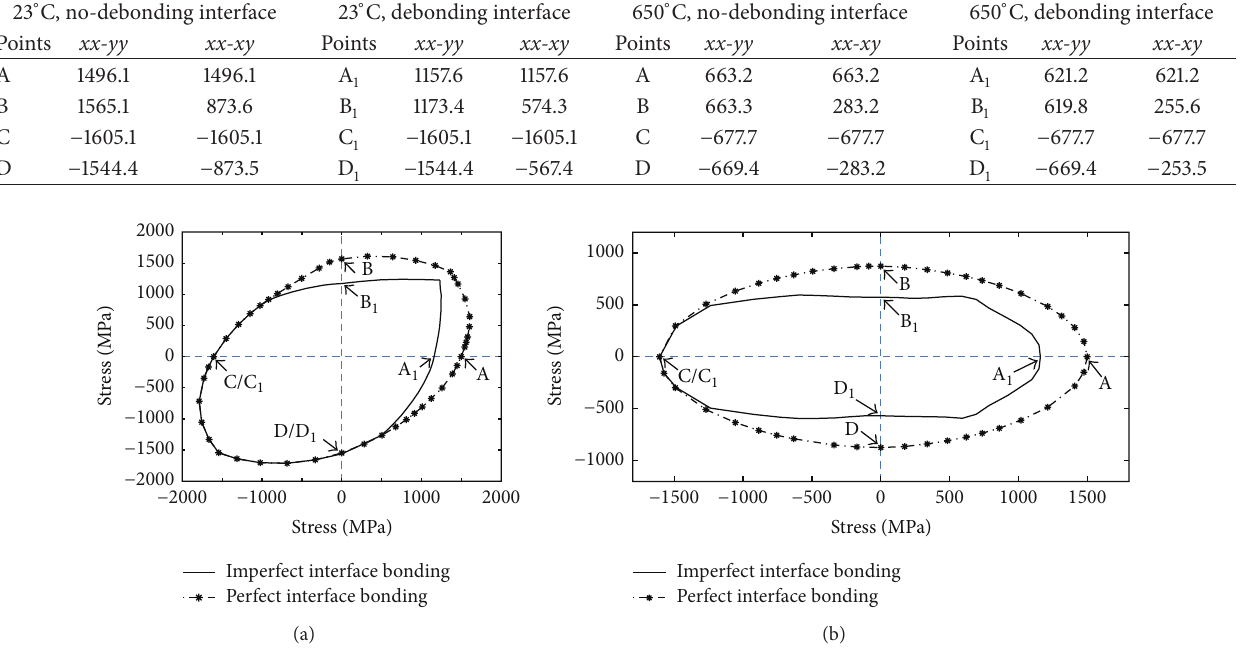
laminate at 23 ∘ C: (a) xx-yy and (b) xx-xy. s